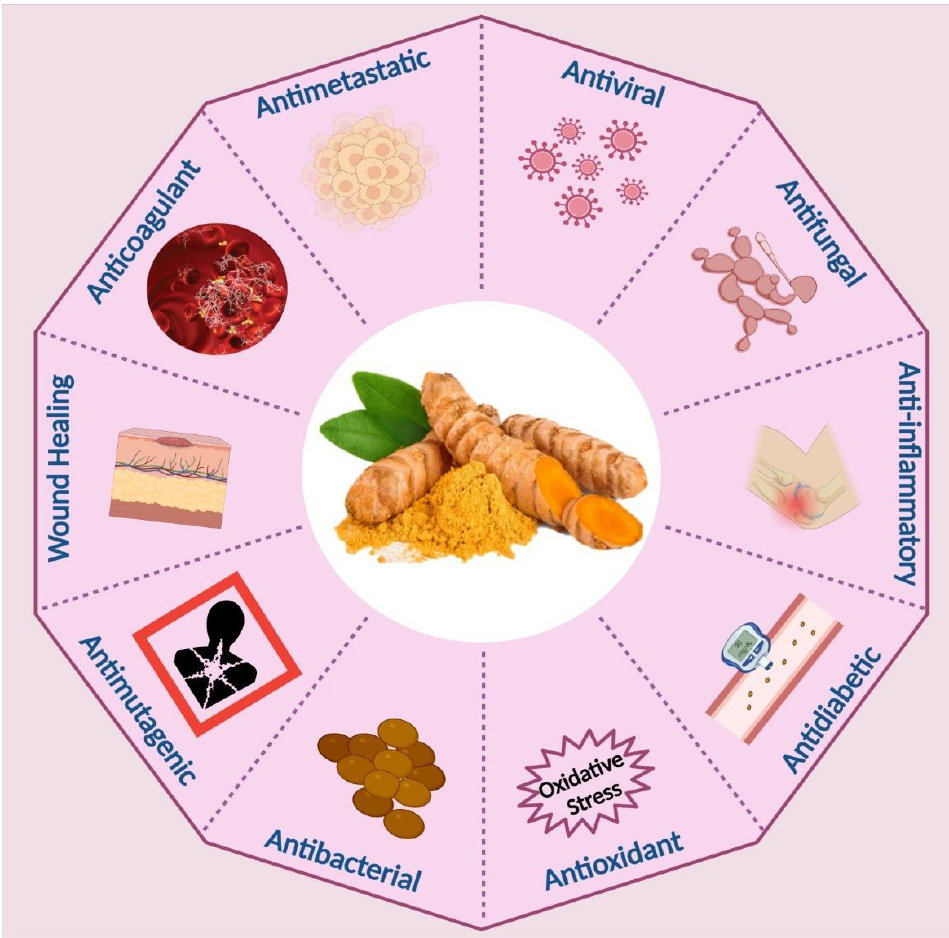
Figure 3. The Potential of Curcumin in Wound Healing. Created with BioRender.com (11 September 2022).